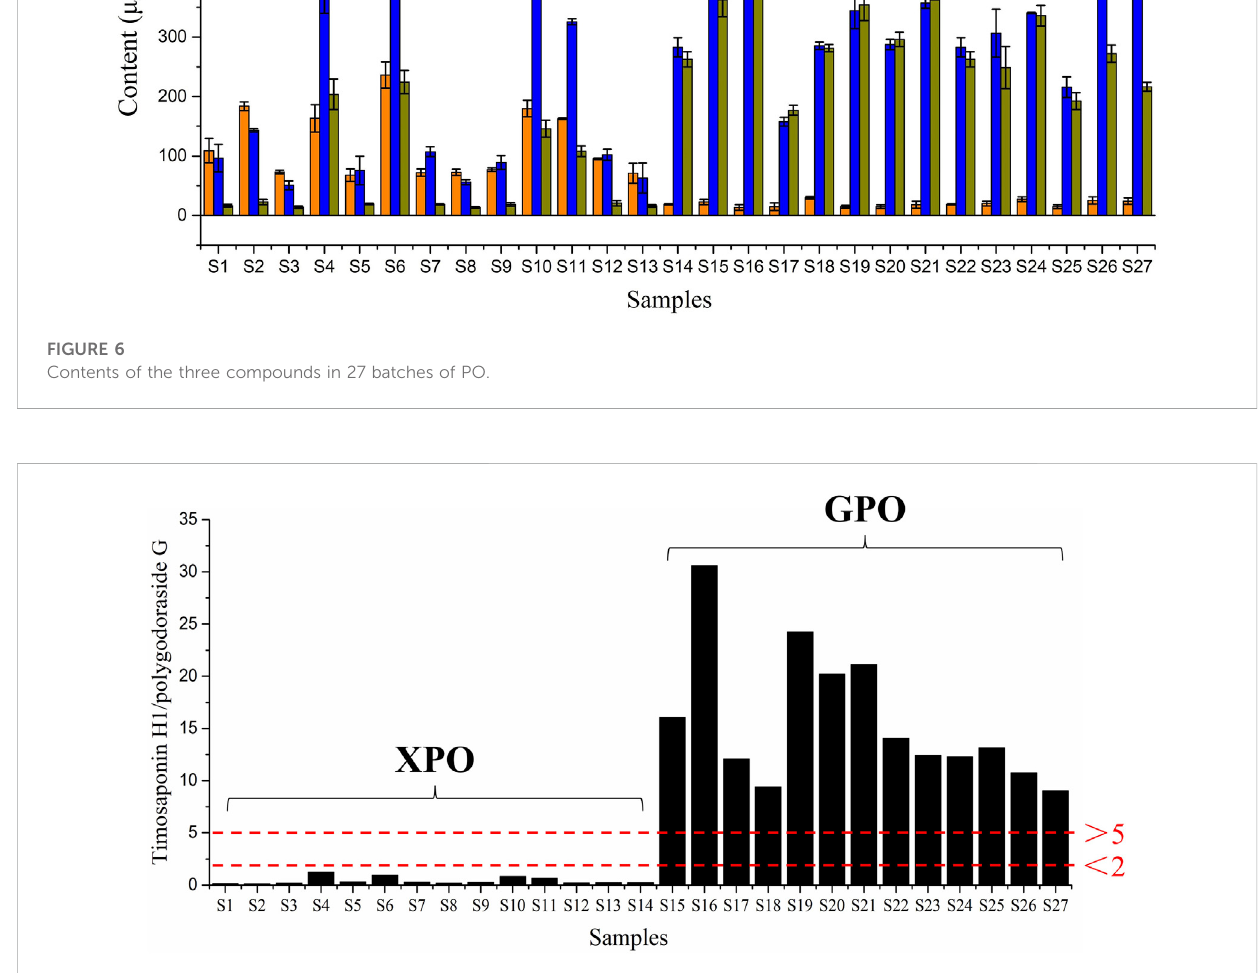
Ratio of timosaponin H1/polygodoraside G in 27 batches of